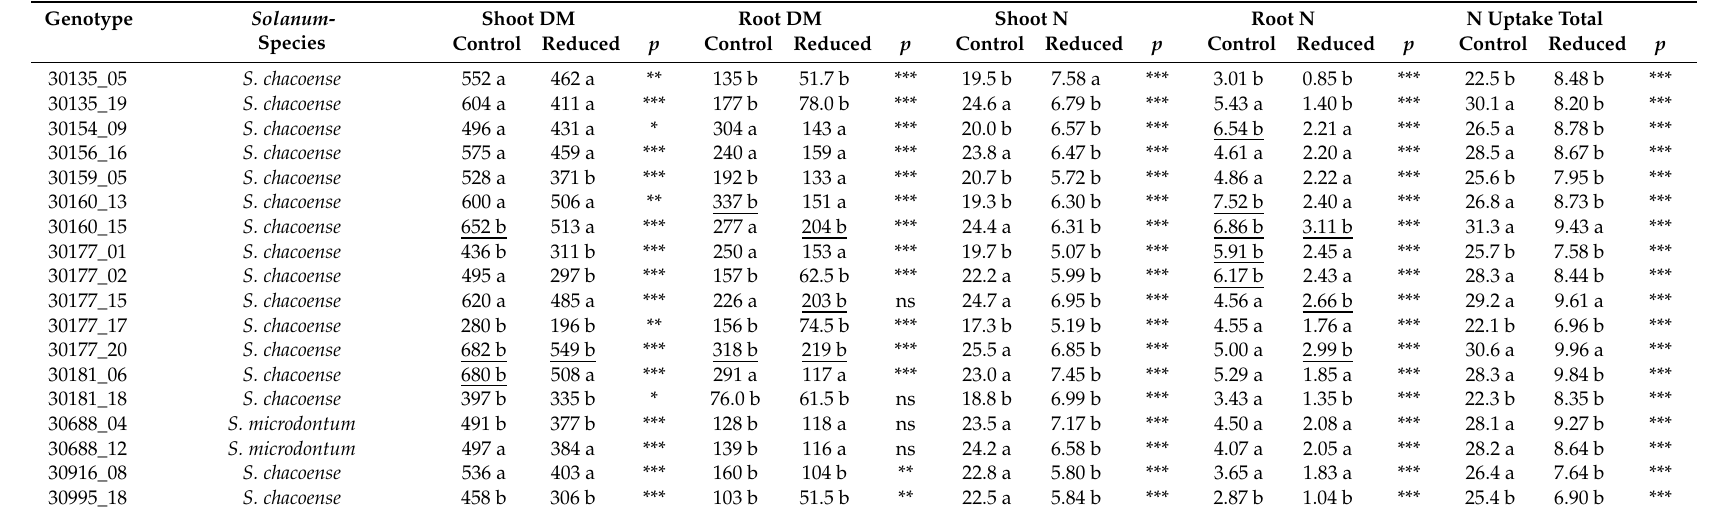
Table 4. Mean dry mass and N uptake of shoots and roots (mg vessel − 1 ) of di ff erent wild potato genotypes cultivated under optimal and reduced N supply for 21 days in a climate chamber. Results of ANOVA and post hoc comparison of